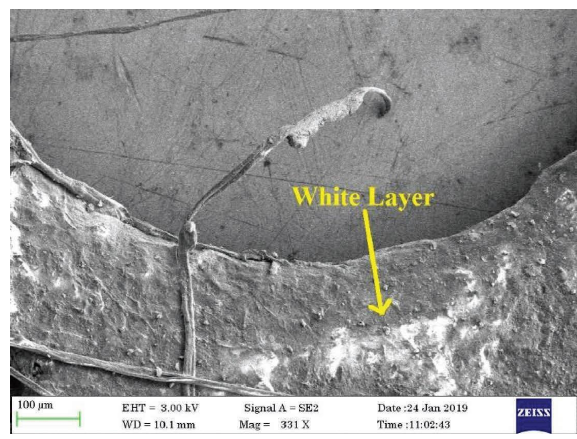
Figure 6: Process parameters efect on